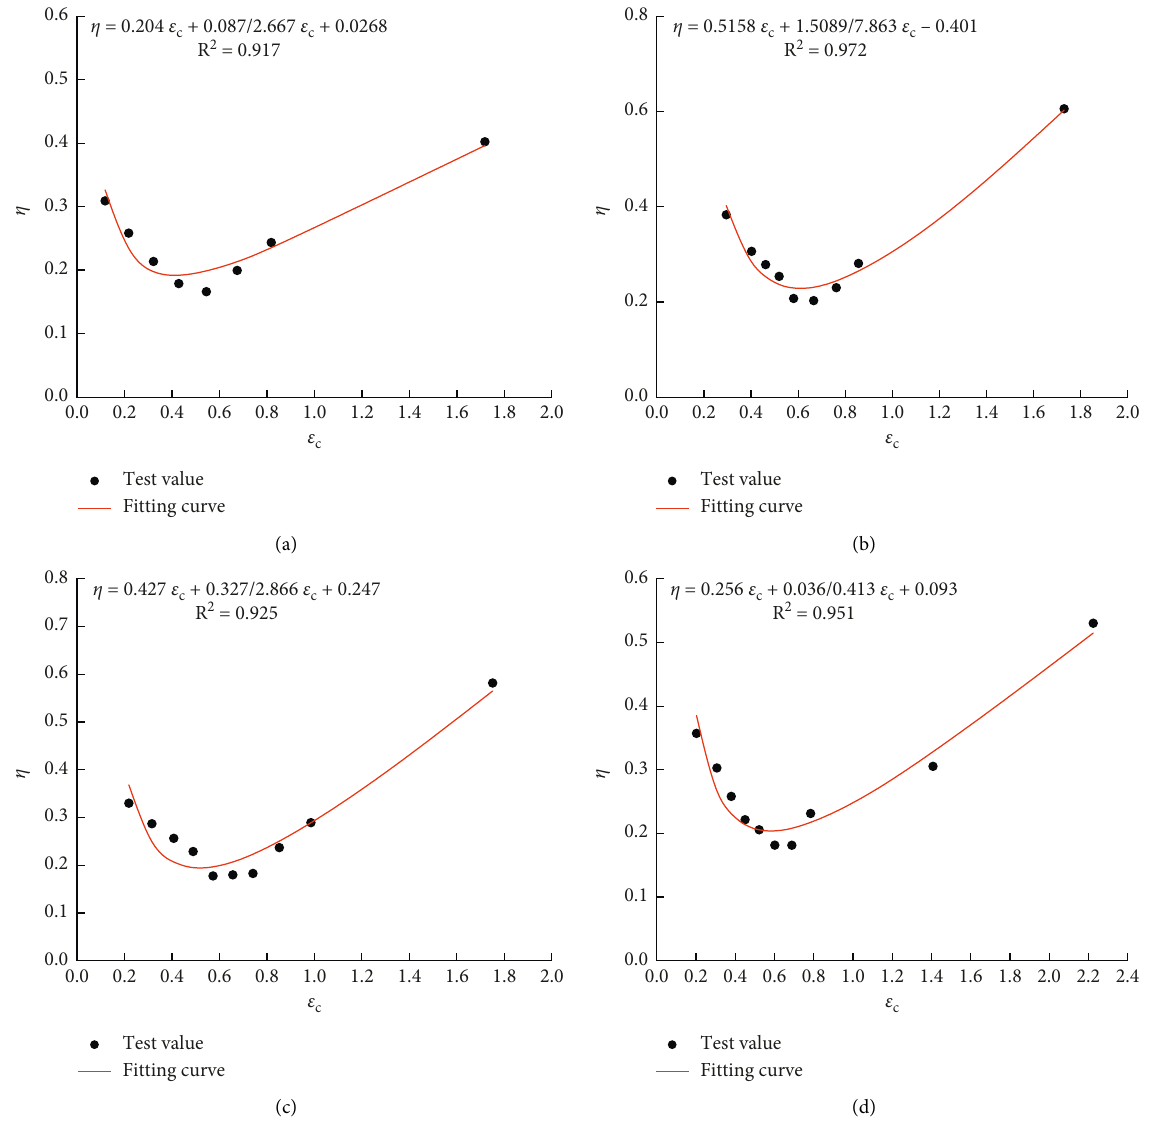
Figure 8: Fitting curves of the energy dissipation ratio-plastic strain under cyclic loading and